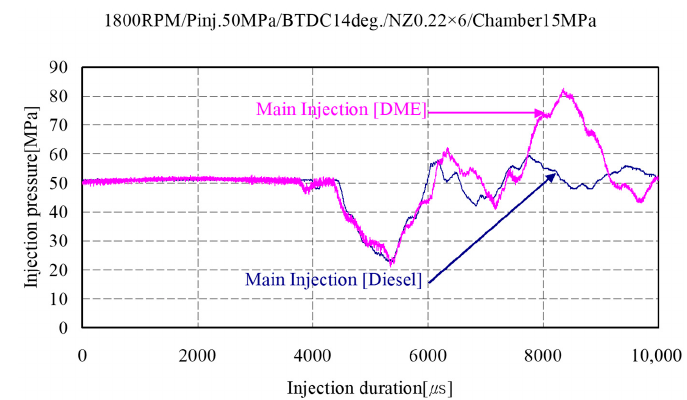
Figure 5. Injection line pressure between the fuel rail and the injector as a function of the following: without pilot injection of the injection duration for diesel and DME.